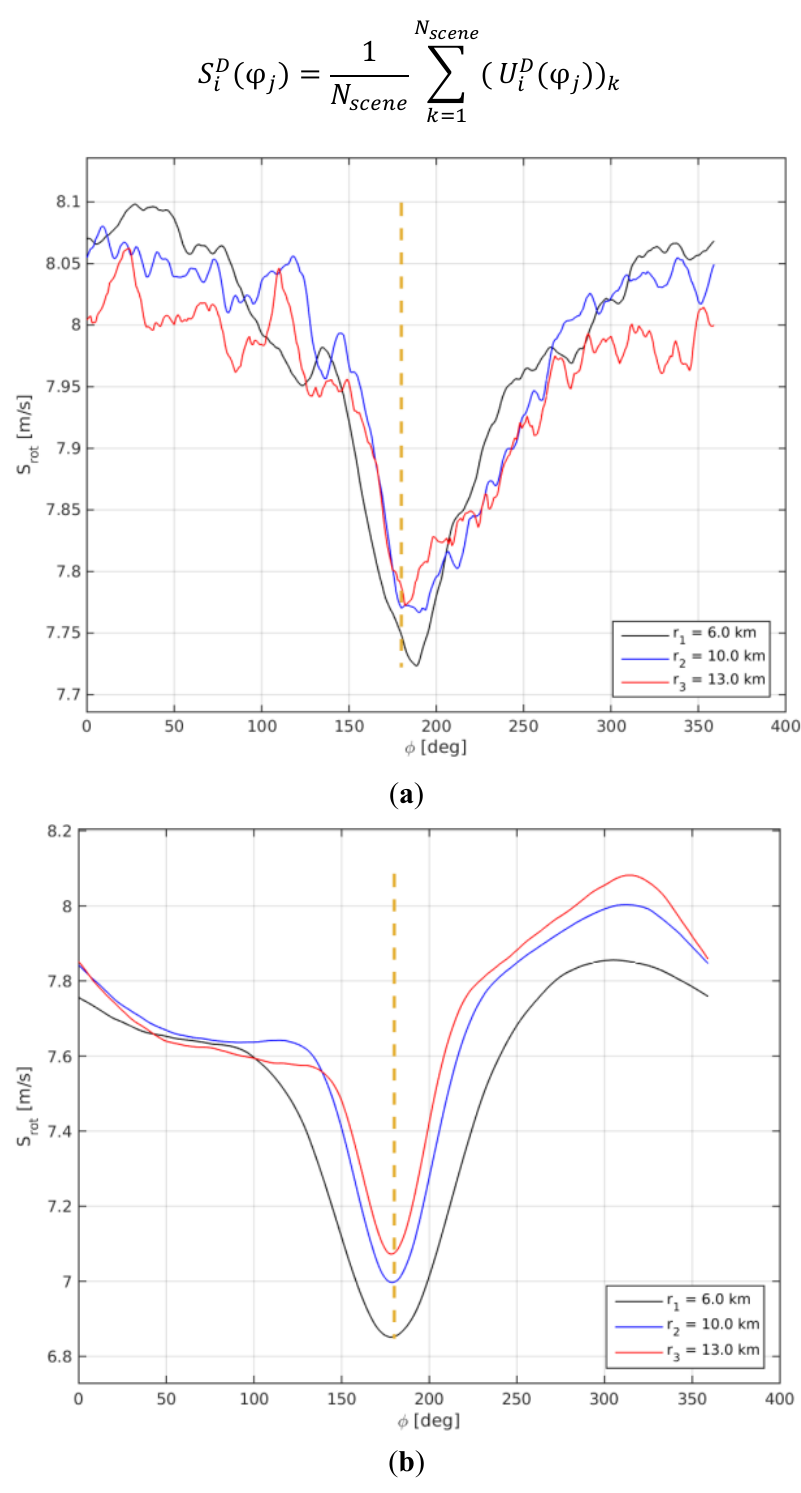
Figure 9. Horns Rev 1 wind speed summations with rotation ( S rot ) based on SAR ( a ) and WRF ( b